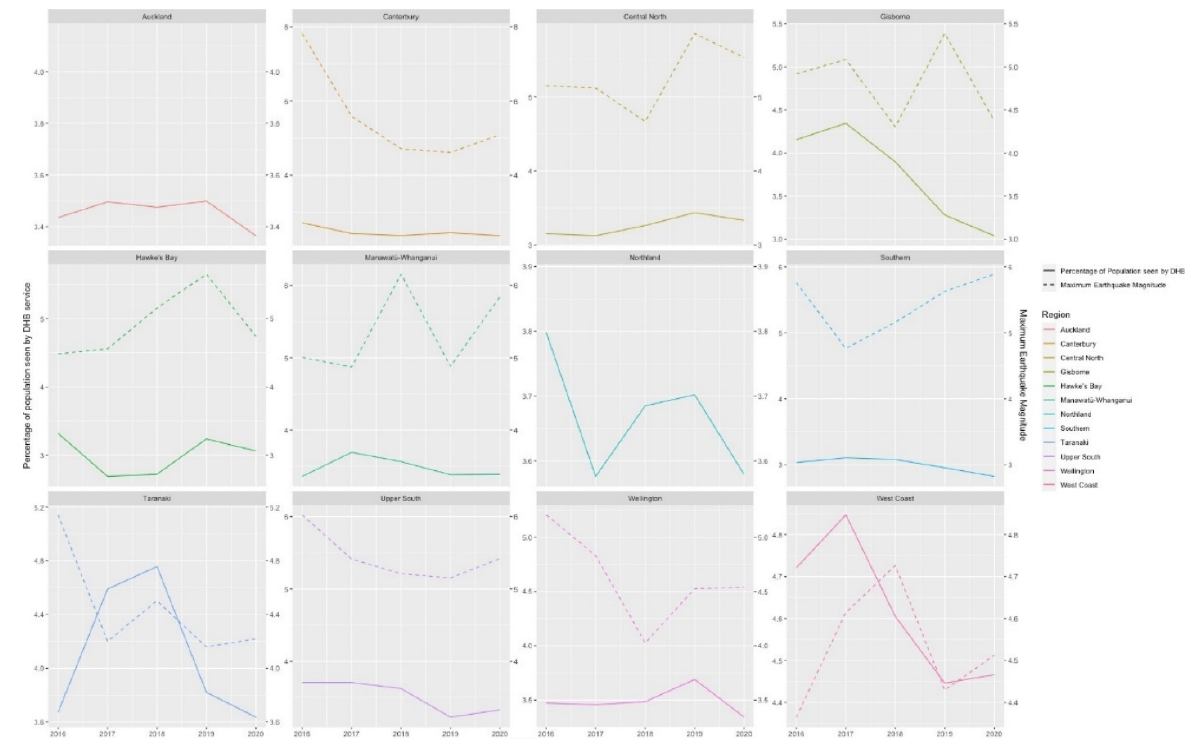
Figure 7. Maximum Earthquake Magnitude compared to Rate of Population seen by